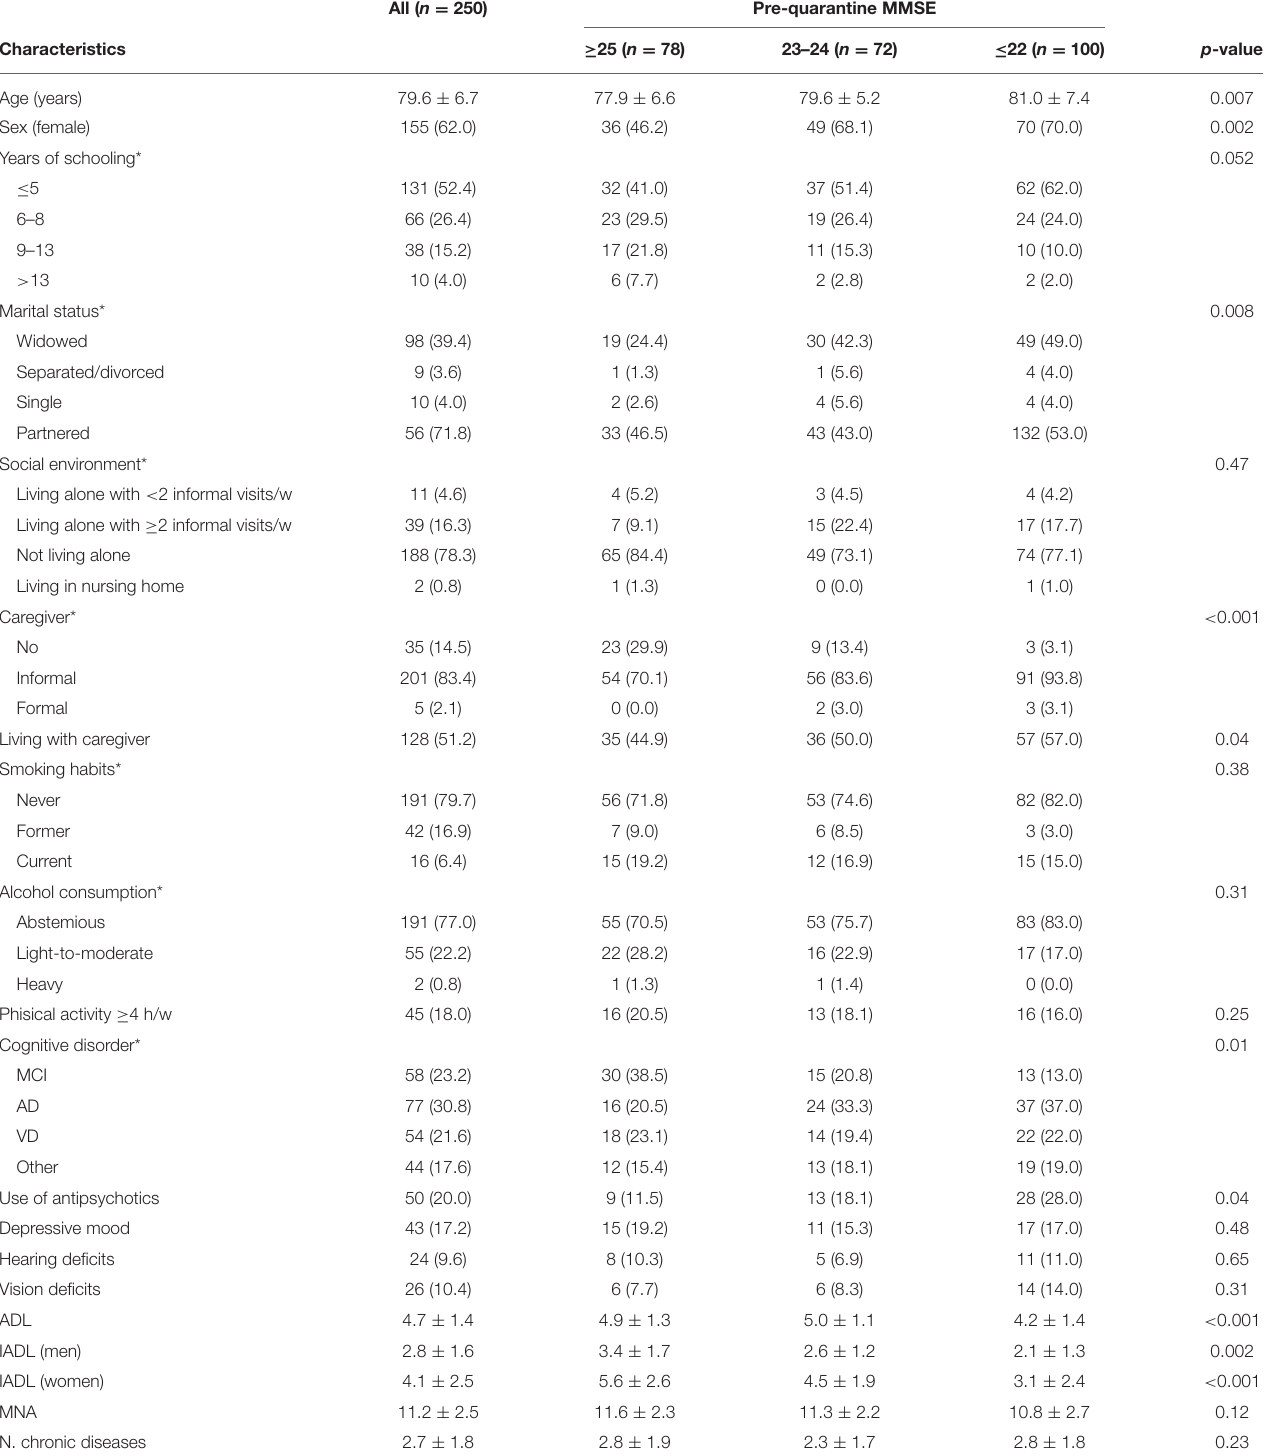
TABLE 1 | Sociodemographic and health-related characteristics of participants by pre-quarantine cognitive functioning. All ( n = 250) Pre-quarantine